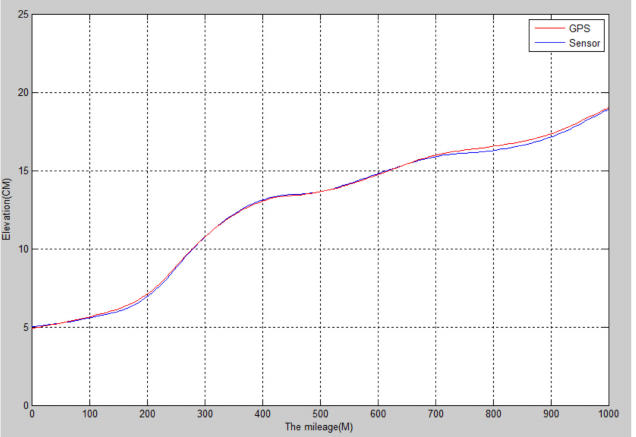
Figure 5. GPS and level road undulation elevation detection